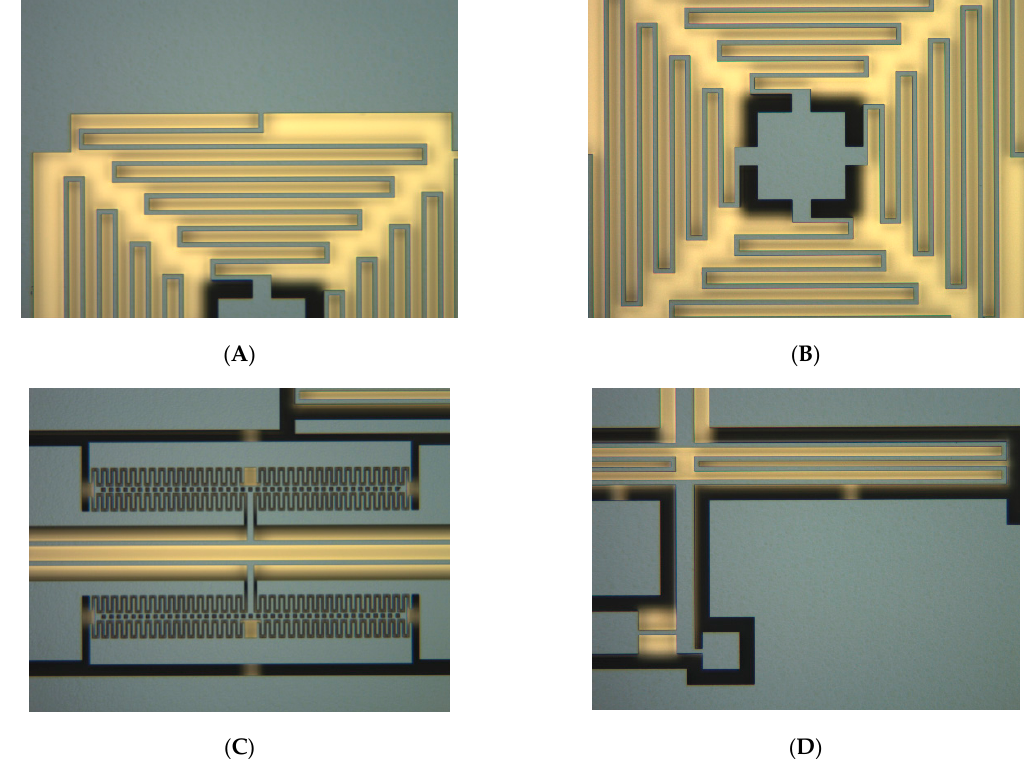
Figure 10. The optical photographs of the fabricated prototype. ( A ) Swing suppression structure. ( B ) The center of the swing suppression structure. ( C ) The double-ended tuning fork resonator. ( D ) The lever elastic beam.